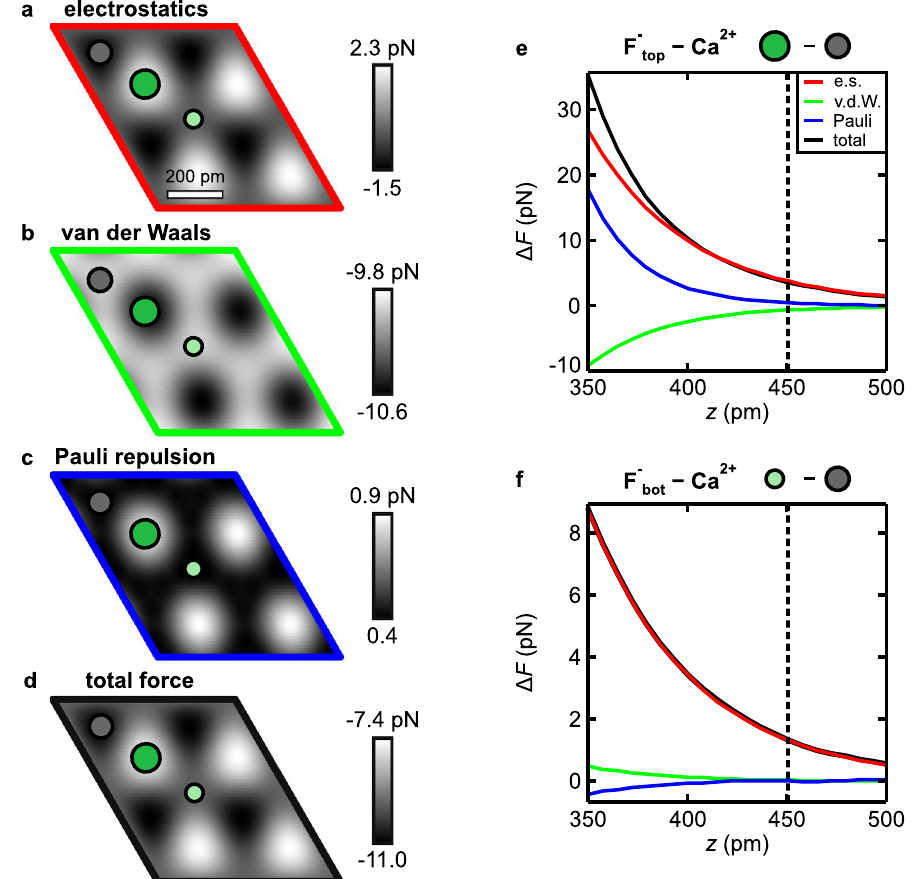
Figure 3. ( a – c ) Interaction decomposed images [of a CaF 2 (111) supercell] at a tip-sample distance of z = 451 pm , and ( d ) the total force obtained by summing all three contributions obtained with the probe particle model. ( e , f ) Individual contributions to the atomic force contrasts (cid:31) F as a function of tip-sample distance z . The dashed line marks the tip-sample distance of the images in ( a – d ). The colors match the frames of ( a – d